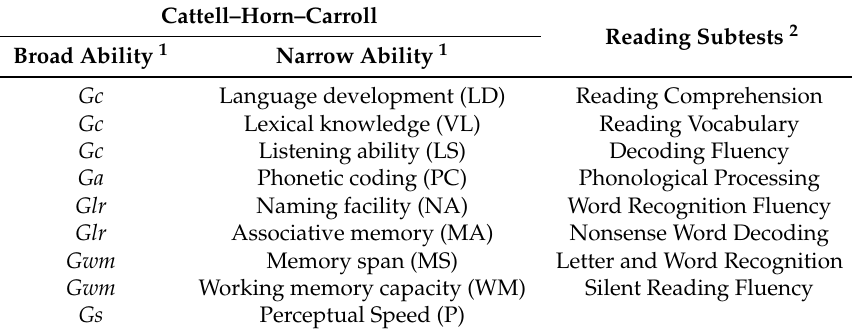
Table 1. Attributes related to reading according to DD/C and sample tests used to assess reading.